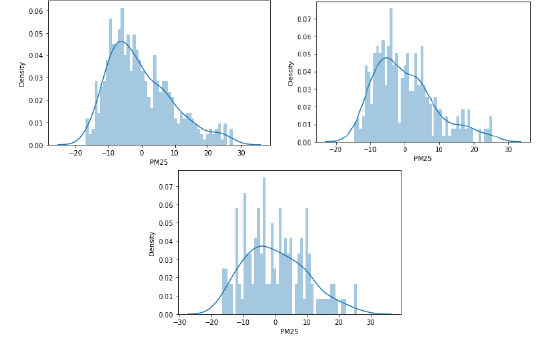
Figure 10. In-situ PM 2.5 residual plots for the yearly model (top left), dry model (top right) and wet model (bottom).